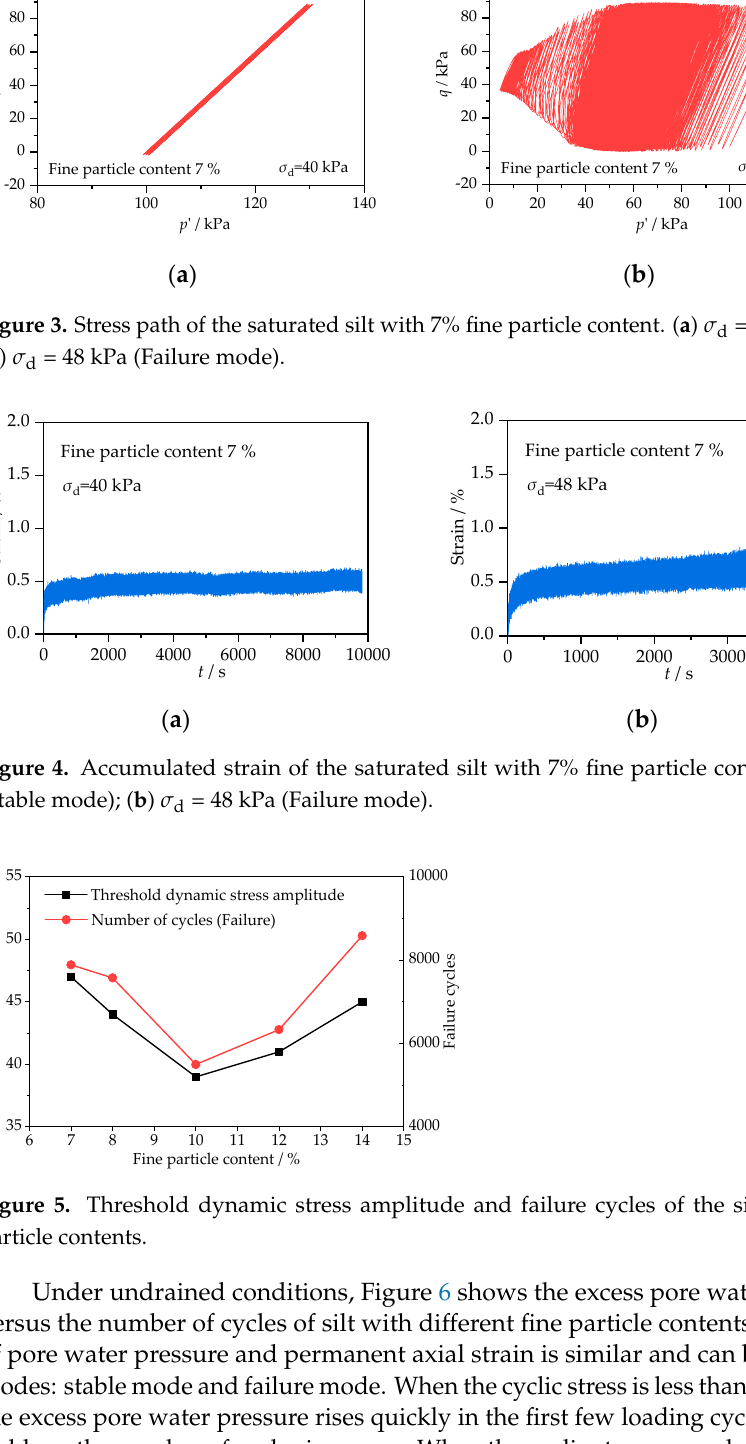
Figure 5. Threshold dynamic stress amplitude and failure cycles of the silt with different fine parti ‐ cle contents.